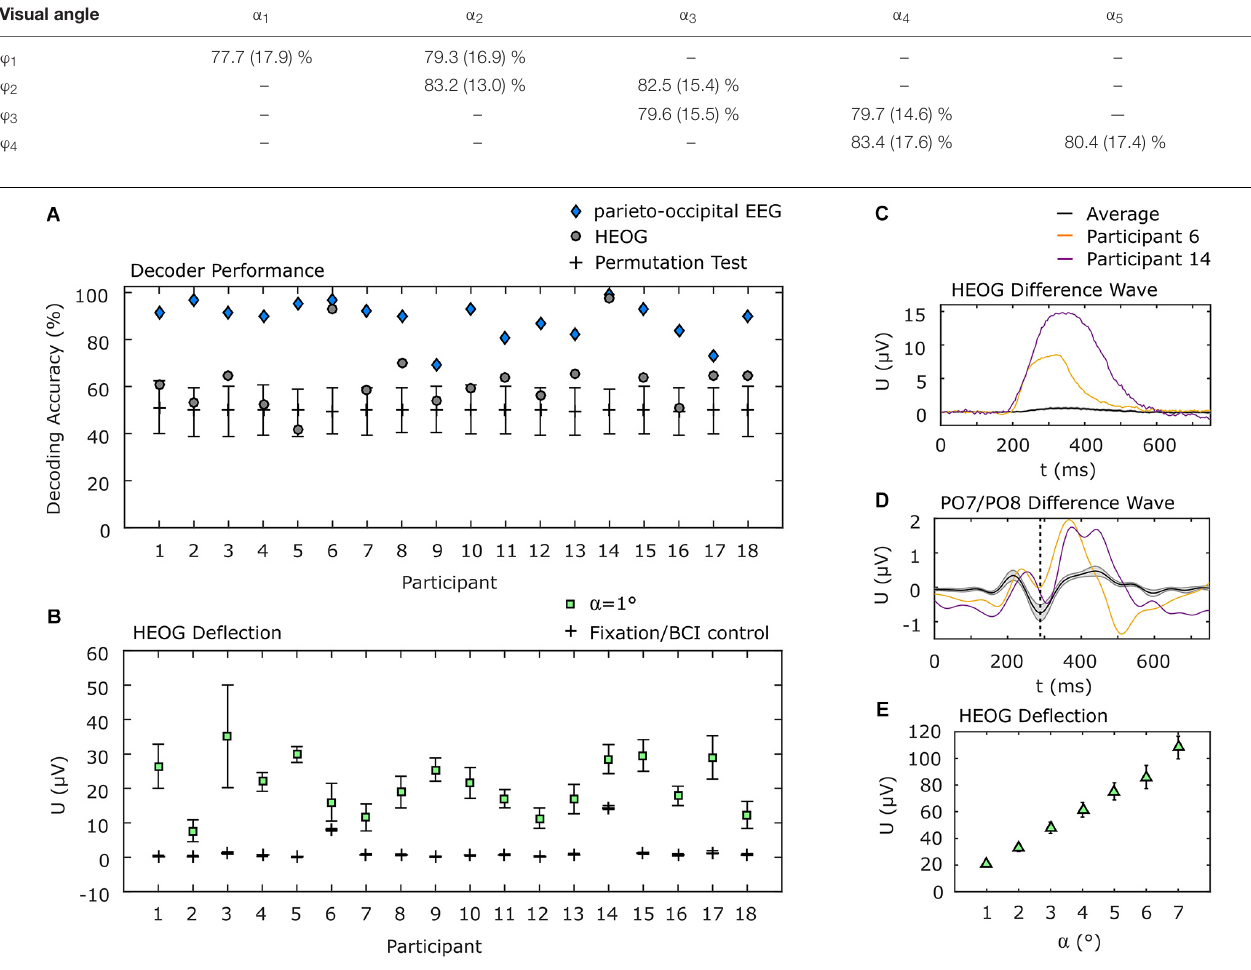
FIGURE 5 | EOG analysis. (A) Individual decoding accuracies achieved with EOG and with parieto-occipital EEG. EOG decoding accuracies for participants 6 and 14 were above 90% but below those achieved using EEG. Error bars indicate the 95% confidence interval of a permutation test. (B) Individual horizontal EOG deflections. Here the same two participants also show higher deflections during BCI use, but they are still below the deflection measured when 1 ◦ movements were requested in a calibration procedure. All other participants show almost no deflections during BCI use. (C) EOG difference wave between left and right target presentation. Participants 6 and 14 show considerably higher EOG deflection compared to the average. (D) PO7/PO8 difference wave. Participants 6 and 14 show the N2pc component (dashed vertical line), typically evoked during spatial attention shifts, similar to the average but with higher positive deflection